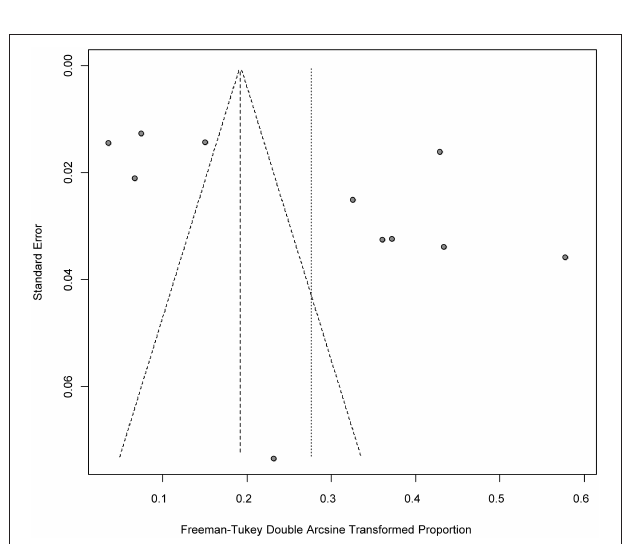
FIGURE 3 | Publication bias of studies by funnel plot (Molecular methods).